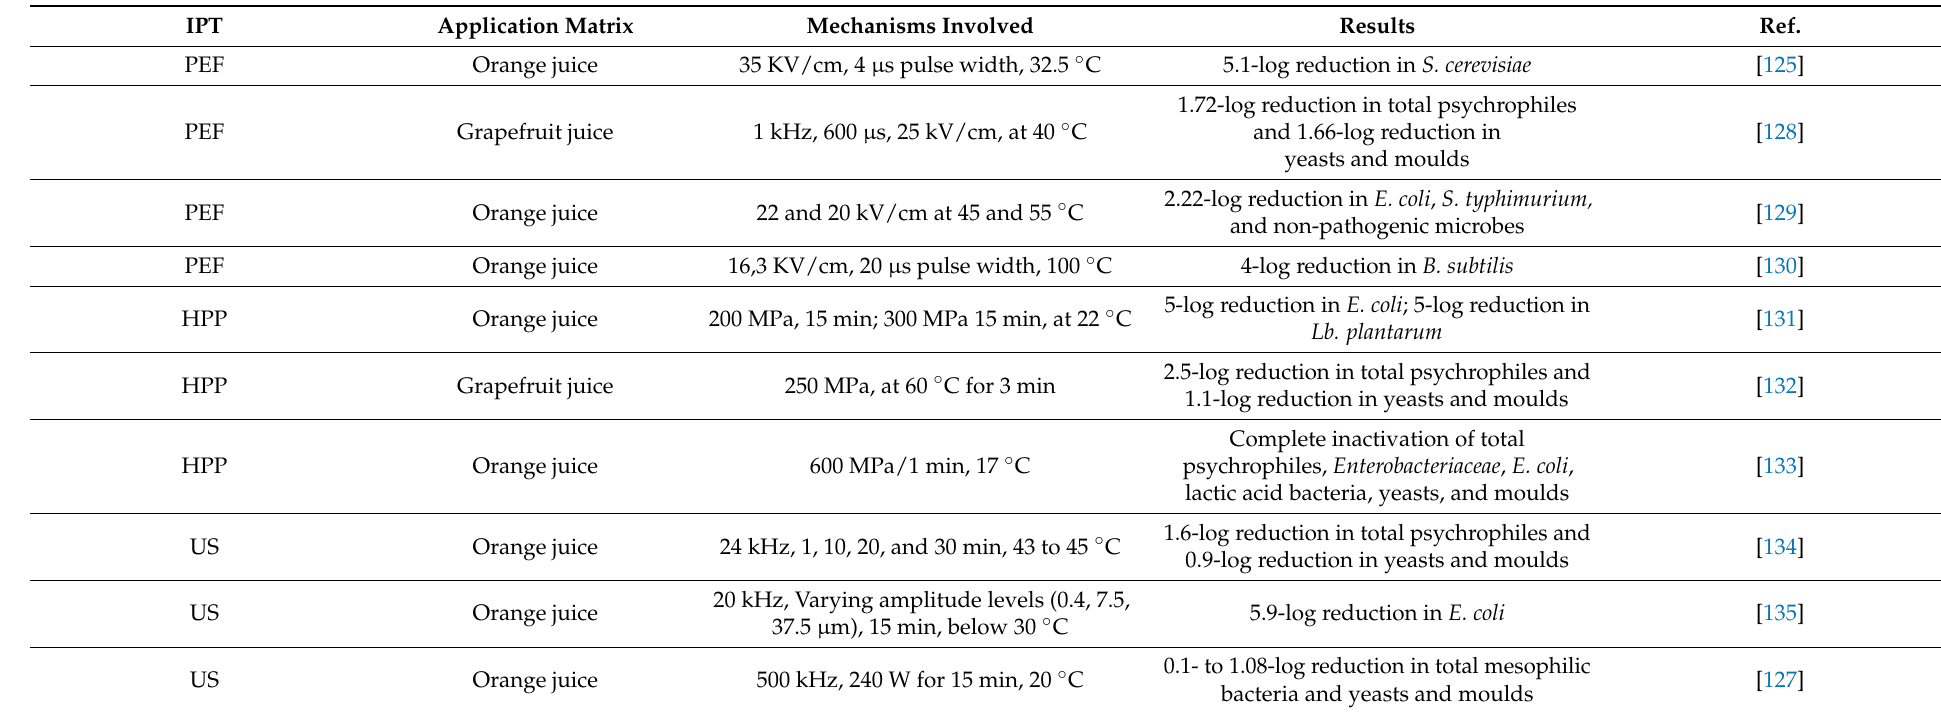
Table 6. Impact of innovative processing technologies on microbiological contamination in citrus